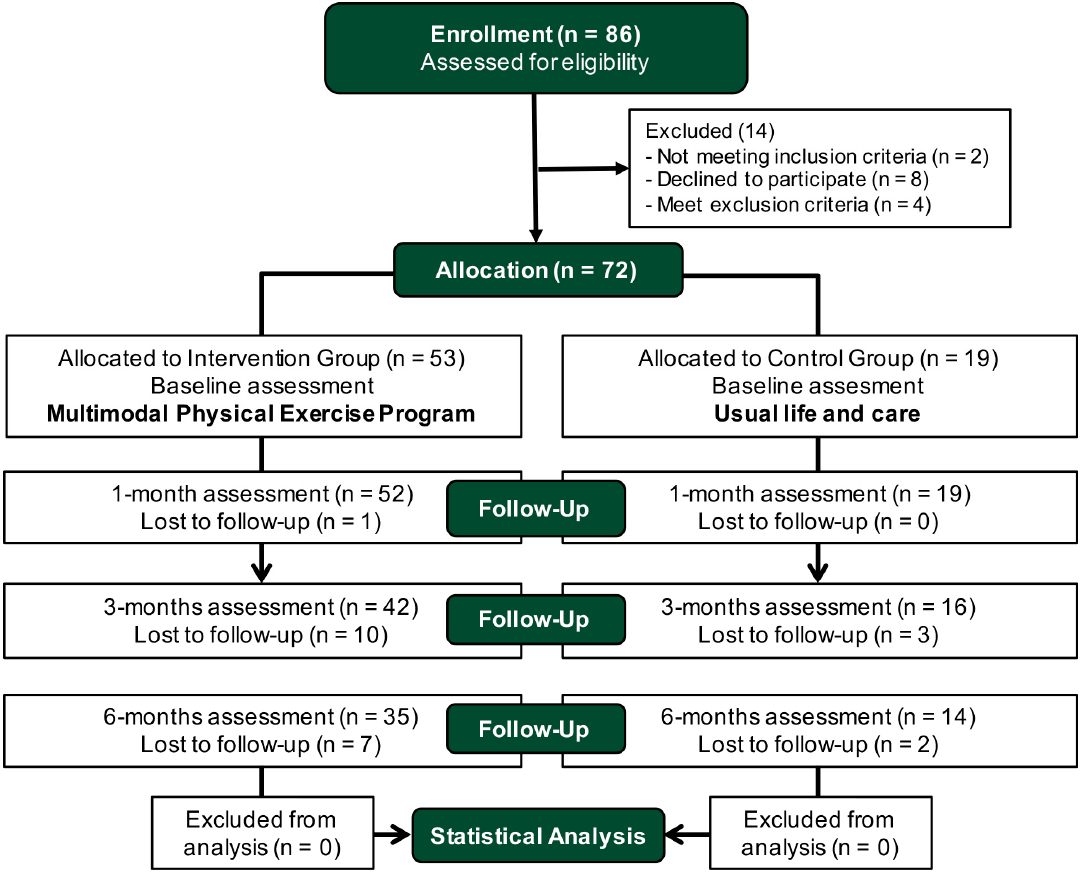
Figure 1. Consolidated Standards of Reporting Trials ( CONSORT) flow diagram.